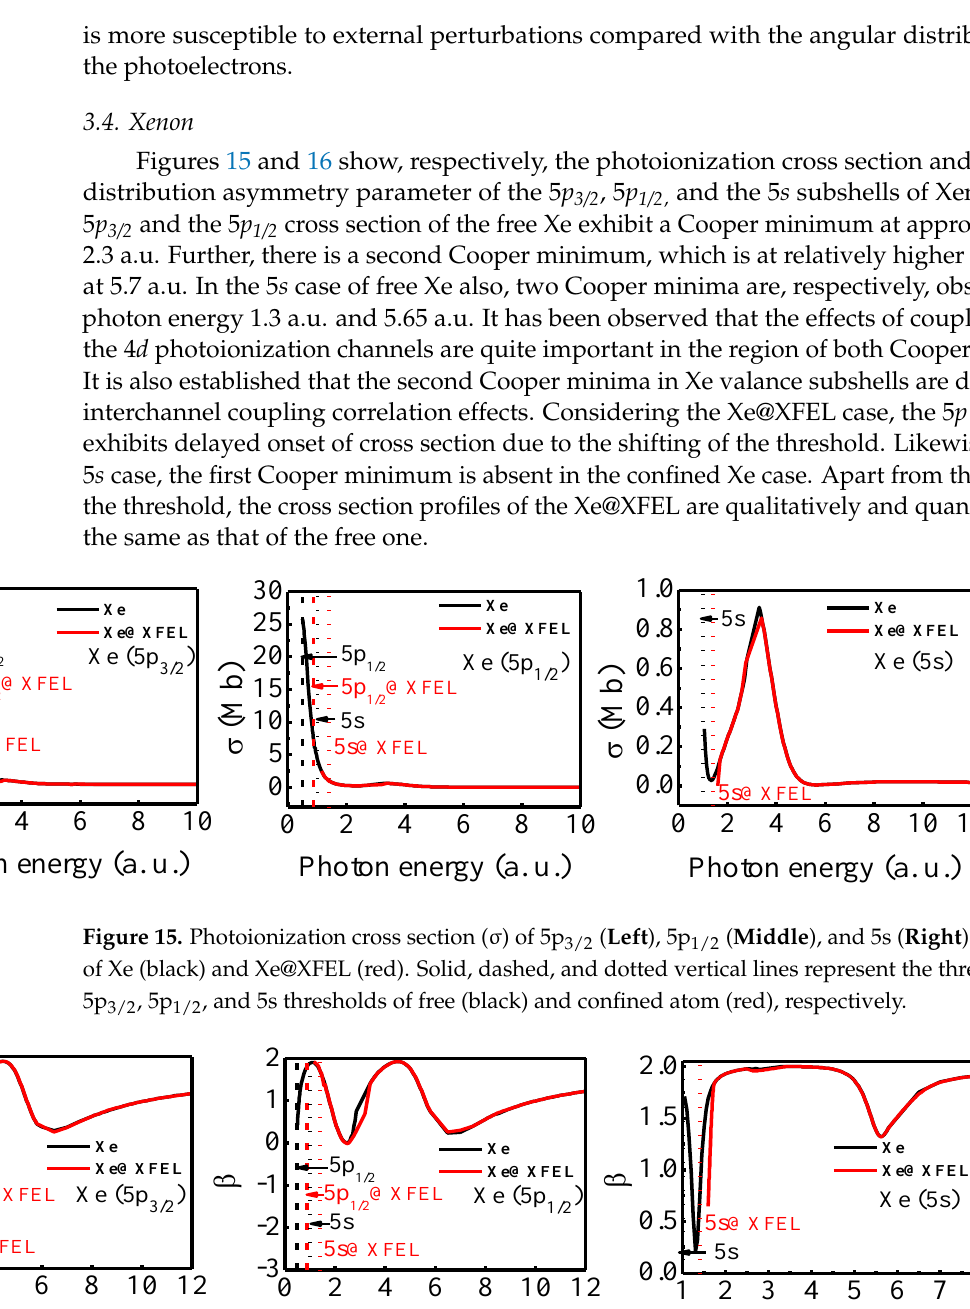
Figure 14. The time delay difference of 4s and 4p subshell (τ(4s)-τ(4p)) of Kr (black) and Kr@XFEL (red) in the RRPA calculation. Vertical lines show the 4s subshell threshold for Kr (black) and Kr@XFEl (red).